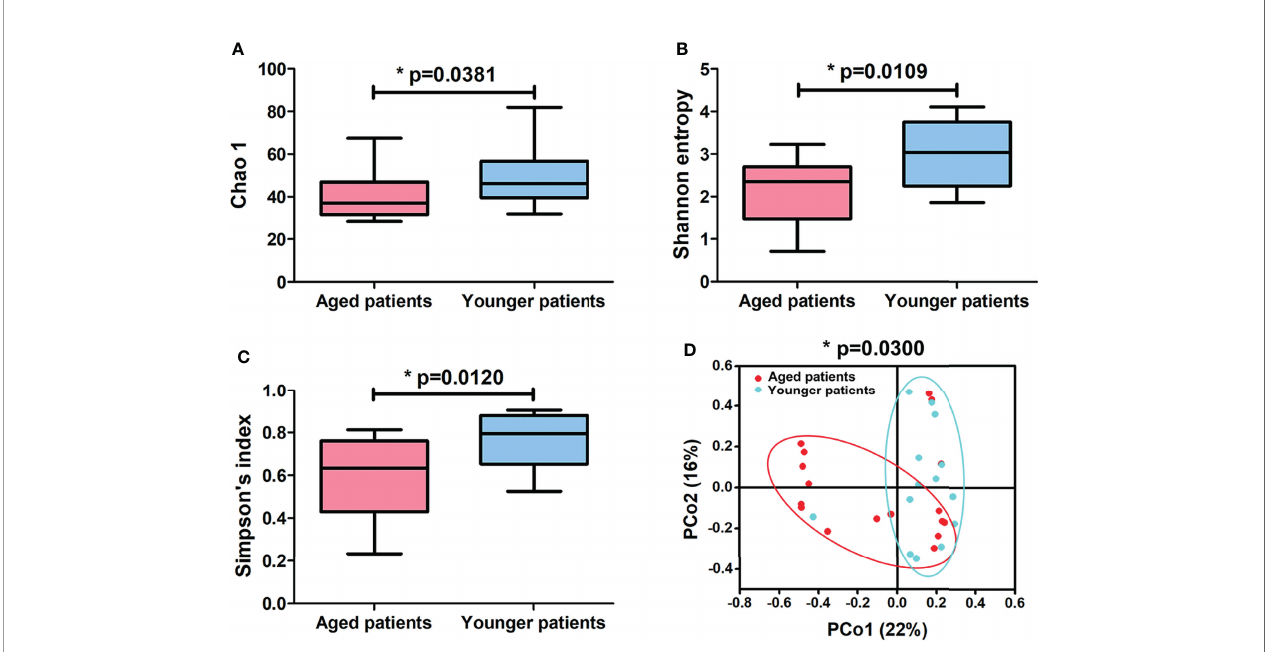
FIGURE 2 | Differences in alpha-diversity indexes and principal coordinate analysis (PCoA) of aged and younger patients. Comparison of (A) Chao 1, (B) Shannon entropy and (C) Simpson ’ s index between aged and younger patients. (D) Principal coordinate analysis plot of bacterial community of aged and younger patients according to Bray-Curtis calculation method. A signi fi cant difference in bacterial microbiota (p = 0.0300) between aged and younger patients was shown by permutational multivariate ANOVA (PERMANOVA) on OTUs level according to Bray – Curtis dissimilarity index. *p <